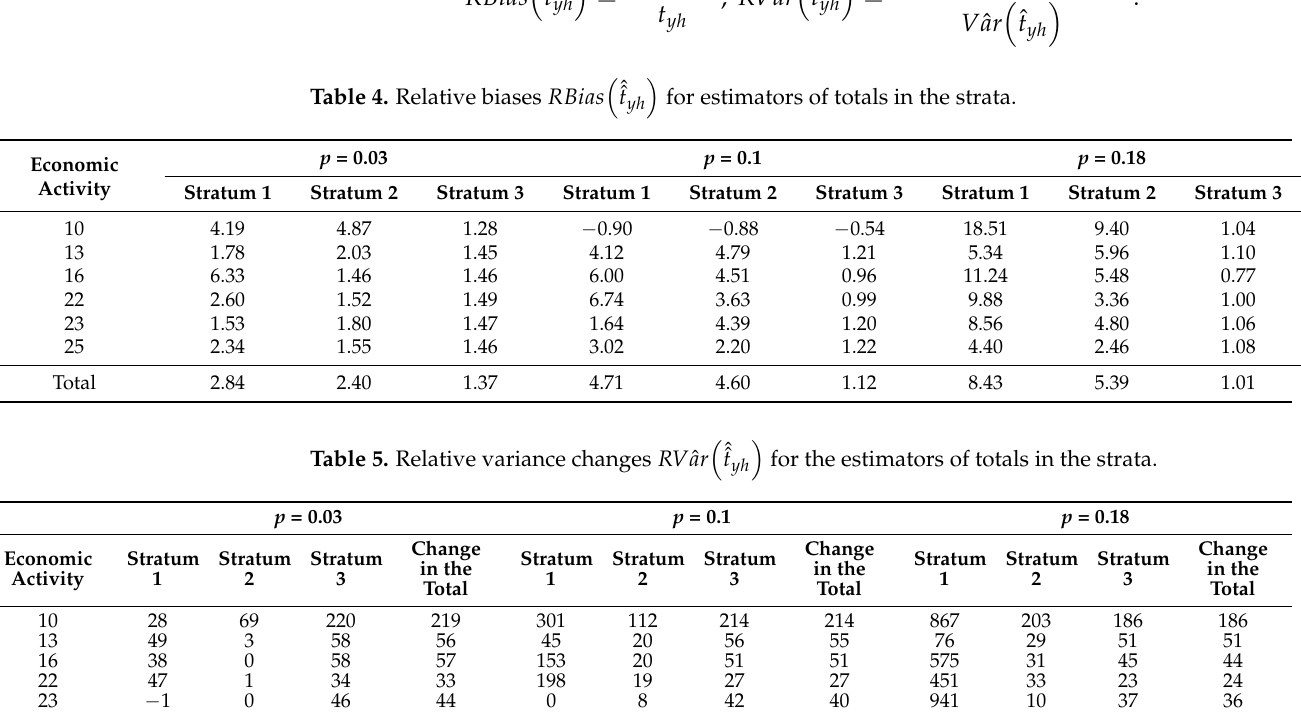
Table 4. Relative biases RBias